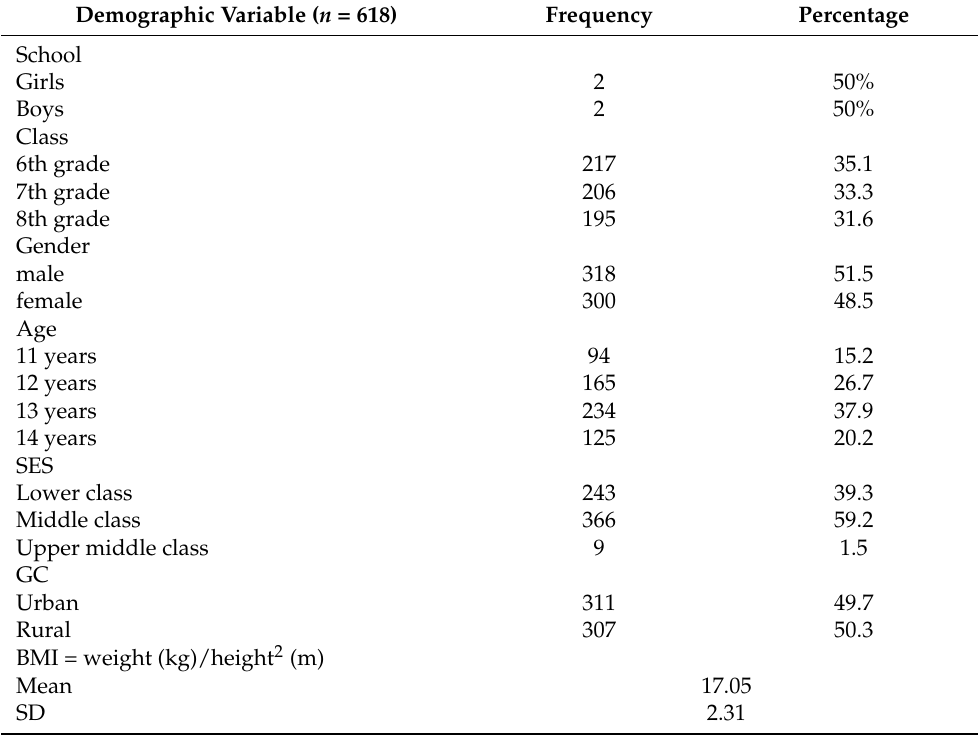
Table 2. Demographic characteristics of the participants.